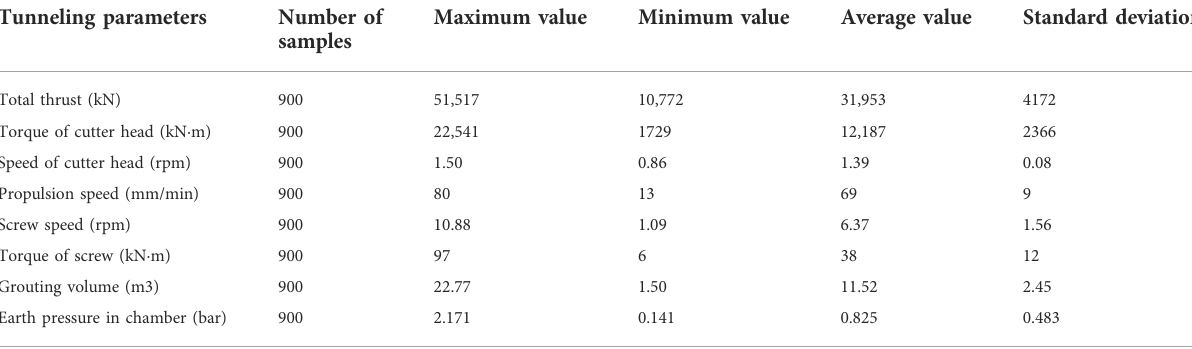
TABLE 1 Statistical distribution of shield machine parameters in shield